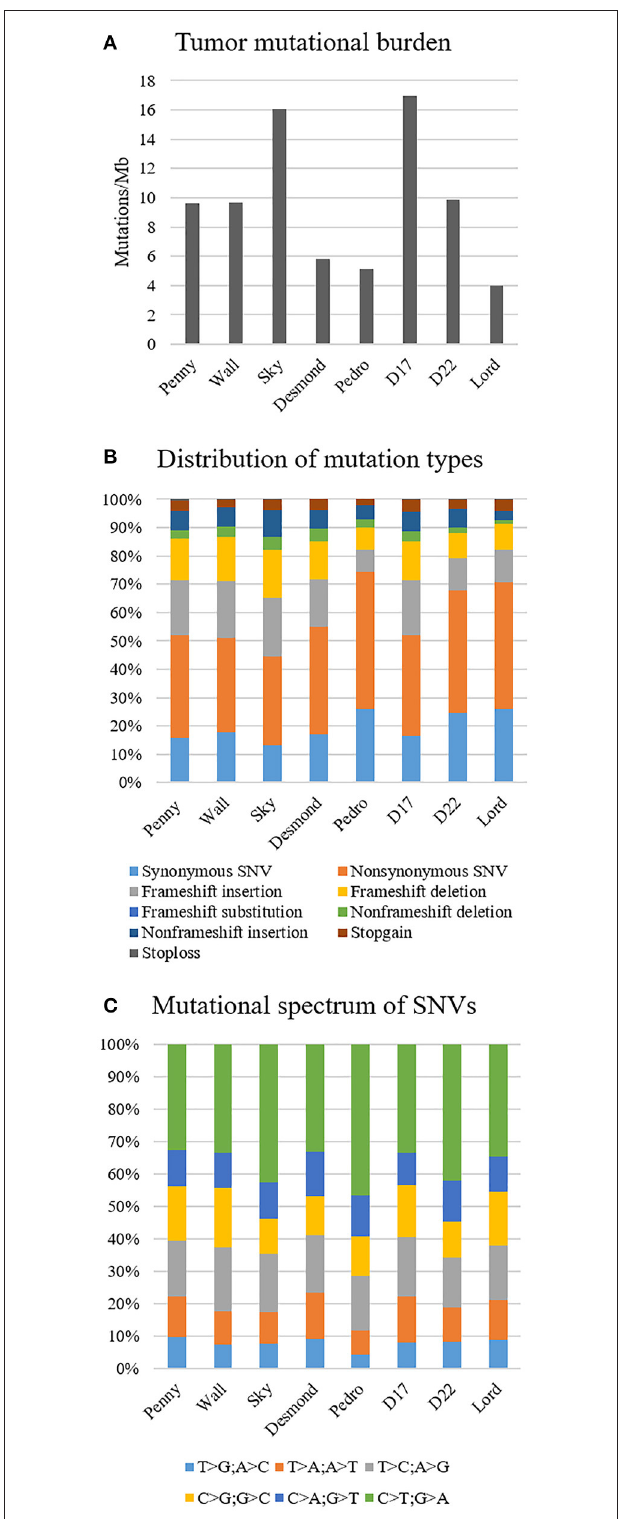
FIGURE 2 | Mutational landscape of canine osteosarcoma cell lines, Level 1 variants. (A) Tumor mutational burden. (B) Distribution of mutation types. (C) Mutational spectrum of single-nucleotide